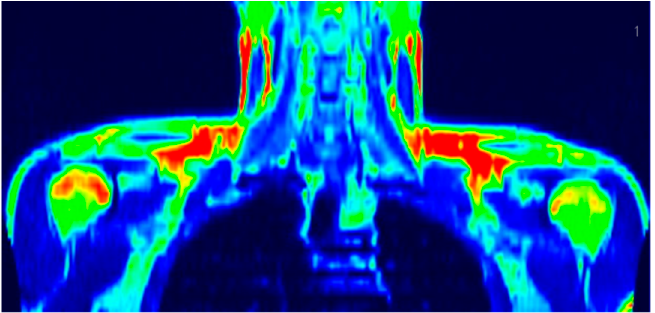
Figure 1. A PET/MR scan image of subject with brown fat depots in supraclavicular regions. The BAT(+) group was characterized by a higher percentage of daily energy intake obtained from protein and a lower percentage of daily energy obtained dietary fat ( p = 0.01, p = 0.02, respectively, after age, daily energy intake, and DXA lean mass) (Figures 2 and 3). We did not notice any significant differences in percentage energy obtained from carbohydrate consumption between the studied groups. Additionally, the groups did not differ in general daily macronutrient intake assessed in grams/day, as mentioned previously [42].